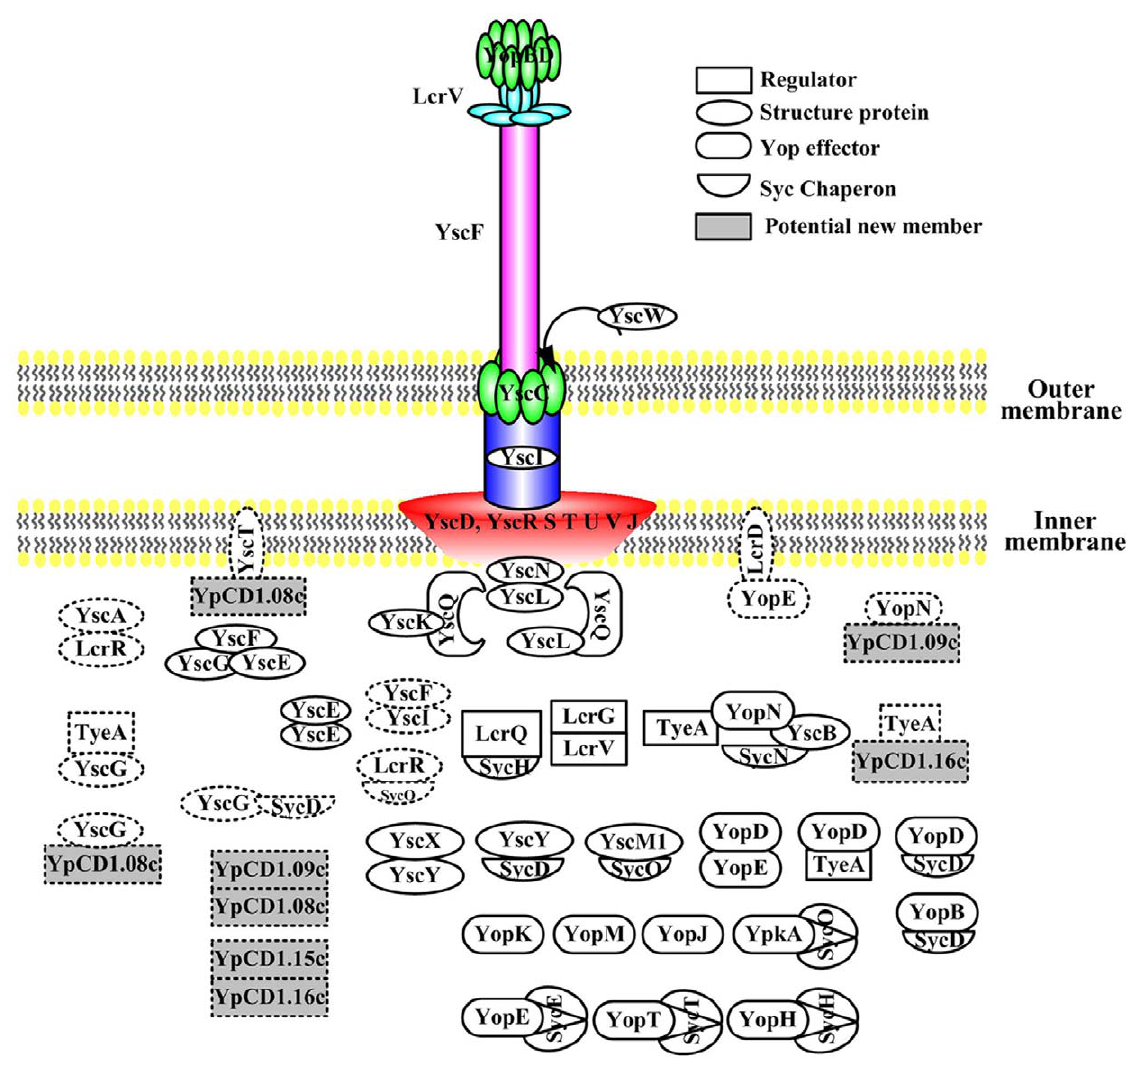
Figure 4. Schematic representation of Yersinia type III secretion apparatus and the protein-protein interactions among the different components. Symbols in dotted line indicate that interactions between these proteins have not been previously reported and were newly identified in this study.